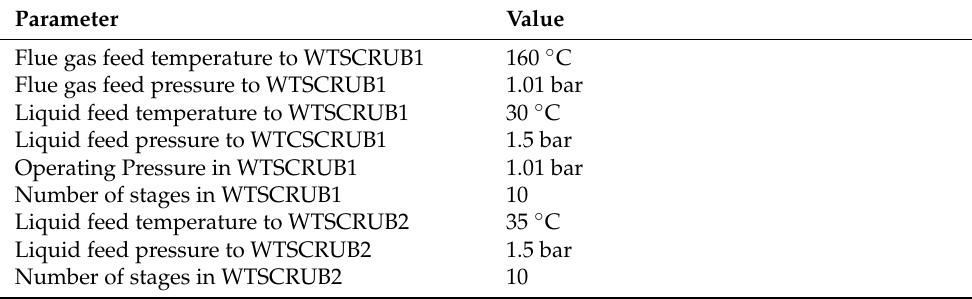
Table 1. Operating conditions in the wet scrubbing process.